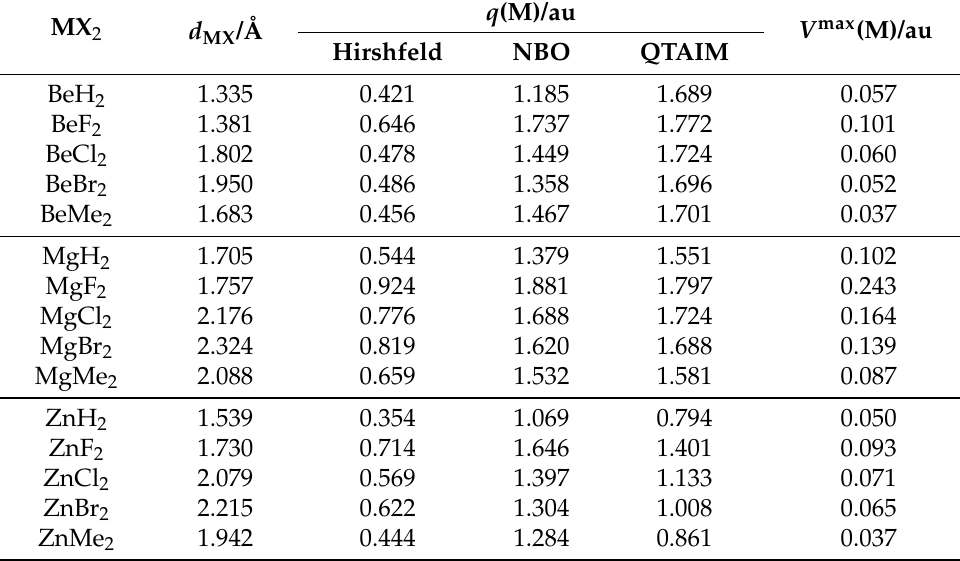
Table 1. Some fundamental data characterizing MX 2 molecules: the length of the M-X bond ( d MX ), the atomic charge (Hirshfeld-, NBO- or QTAIM-based) of M ( q (M)), the maximum value of the electrostatic potential on M ( V max